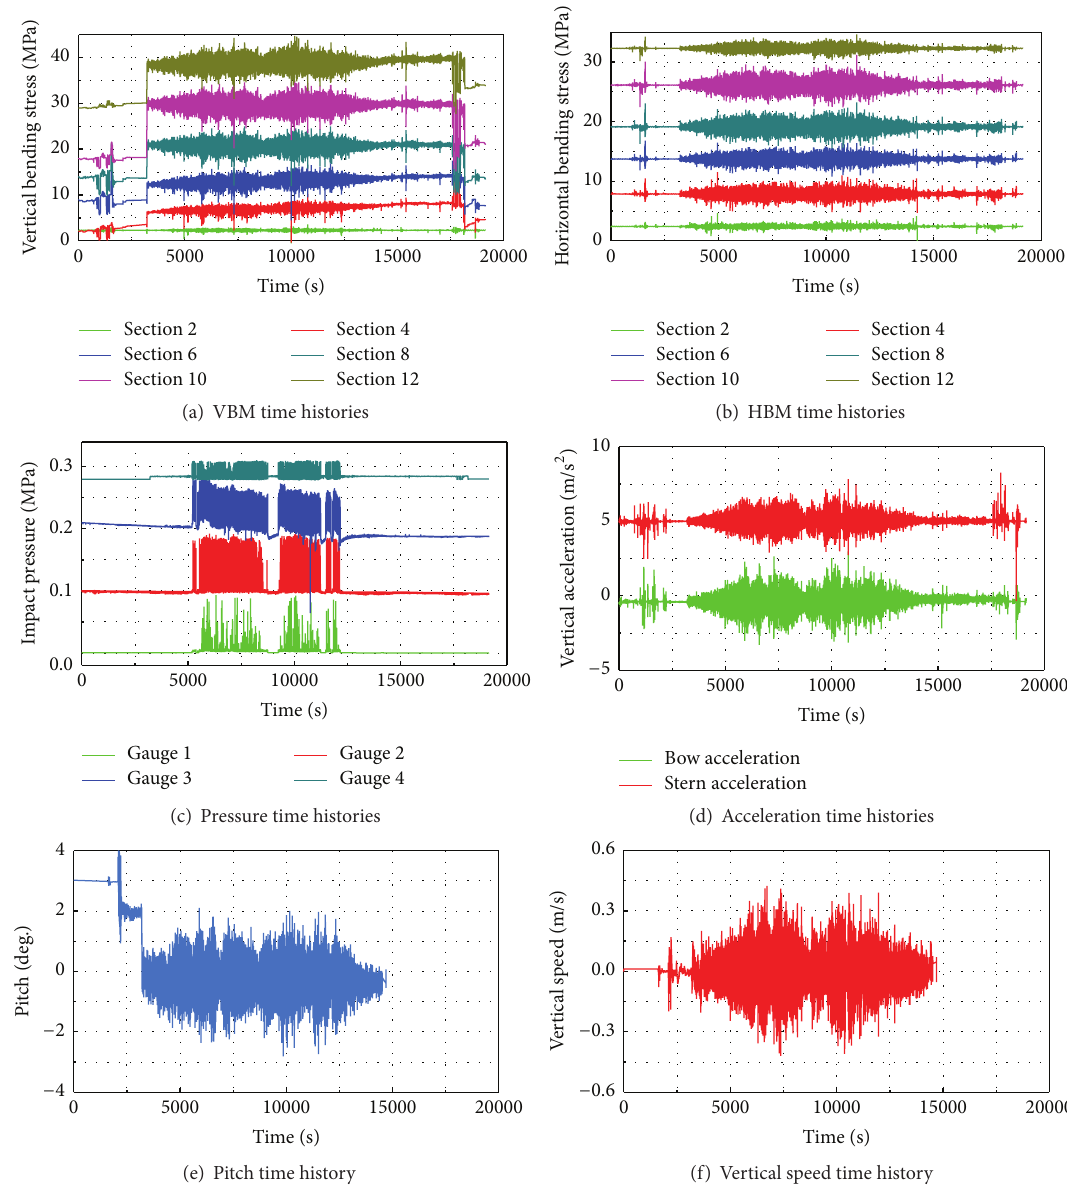
Figure 12: Time histories recorded during the whole trial process.